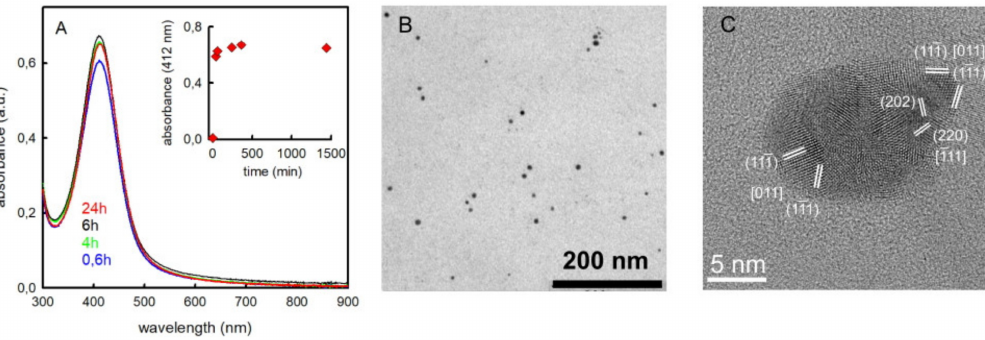
Figure 1. pAgNP-F sample. ( A ): absorbance spectrum measured in the 300–900 nm range. The inset shows the absorbance measured at a wavelength of 412 nm over time (time range: 1500 min). ( B ): conventional transmission electron microscopy (TEM) showing nanoparticles with spheroidal shapes. ( C ): High-resolution transmission electron microscopy (HRTEM) image of a single, representative polycrystalline nanoparticle, showing the {220} and {111} lattice planes of Ag, corresponding to interplanar spacings of 1.44 Å and 2.36 Å. The combinations of interplanar spacings and angular relationships are in accordance with the formation of polycrystalline